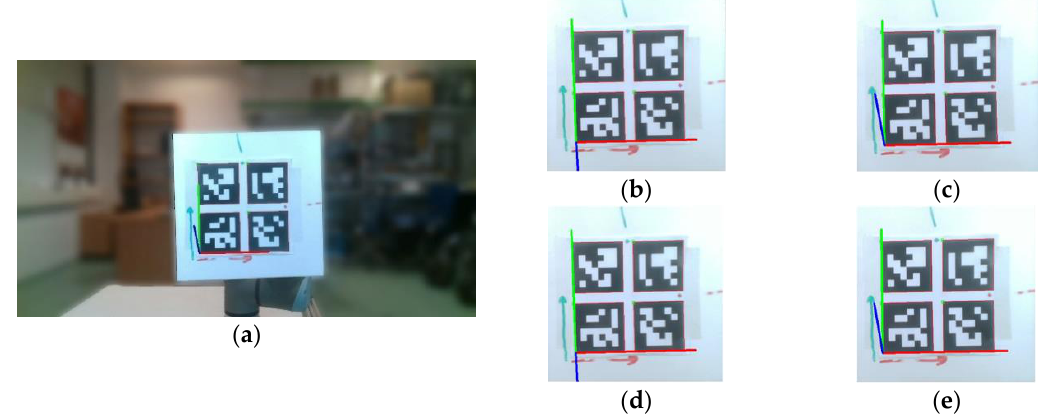
Figure 5. Images from measurements: ( a ) full-frame; ( b – e ) observation in four frames consecutively. The experimental results are visualized in the form of a 30 × 30 matrix of deviations, where the deviations are represented with colors determined by the colour bar in Figure 6.